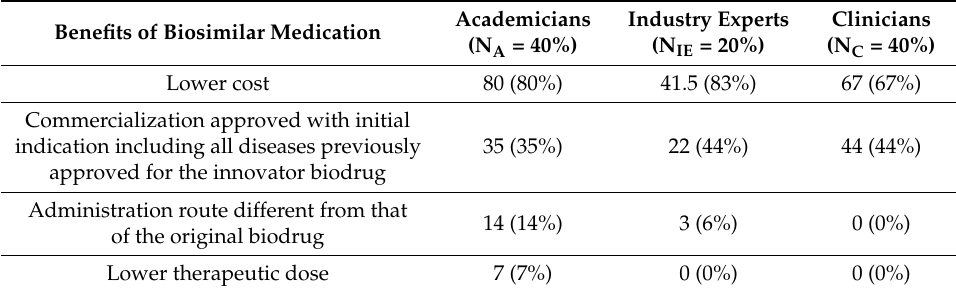
Table 7. Benefits of biosimilars according to Academicians, Industry Experts and